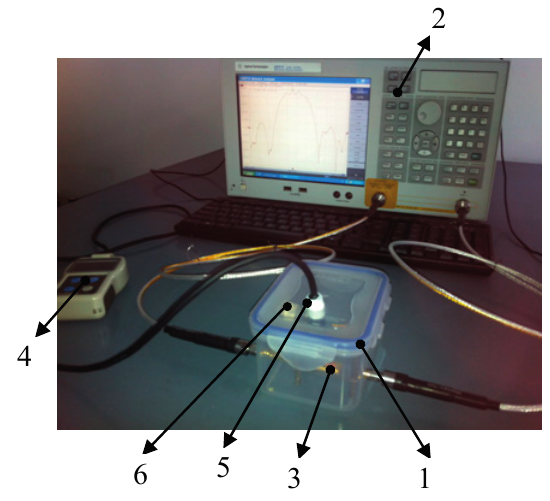
Figure 3. Experimental setup: (1) test box; (2) network analyzer; (3) Love wave device; (4) standard hygrometer; (5) probe of the hygrometer; (6) inlet/outlet for silica particles and wet